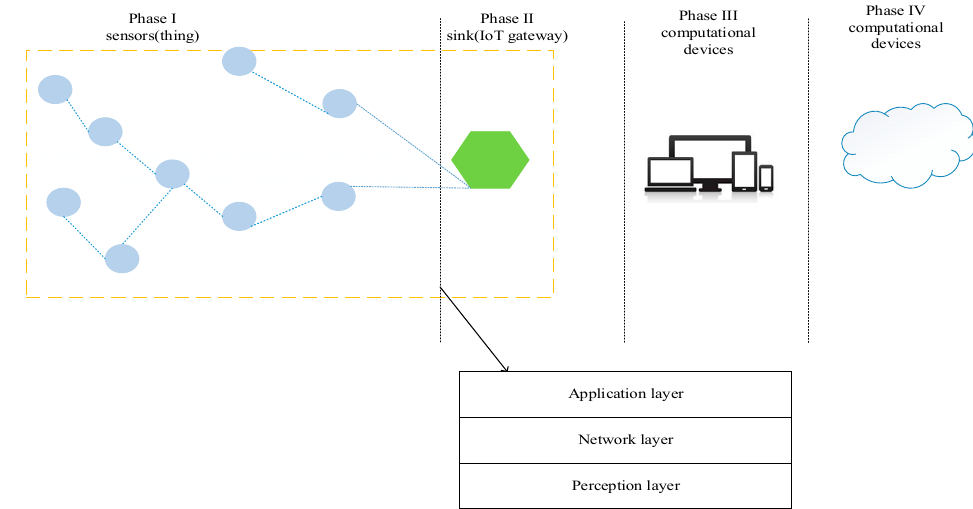
Figure 1. The IoT architecture: three-layer.